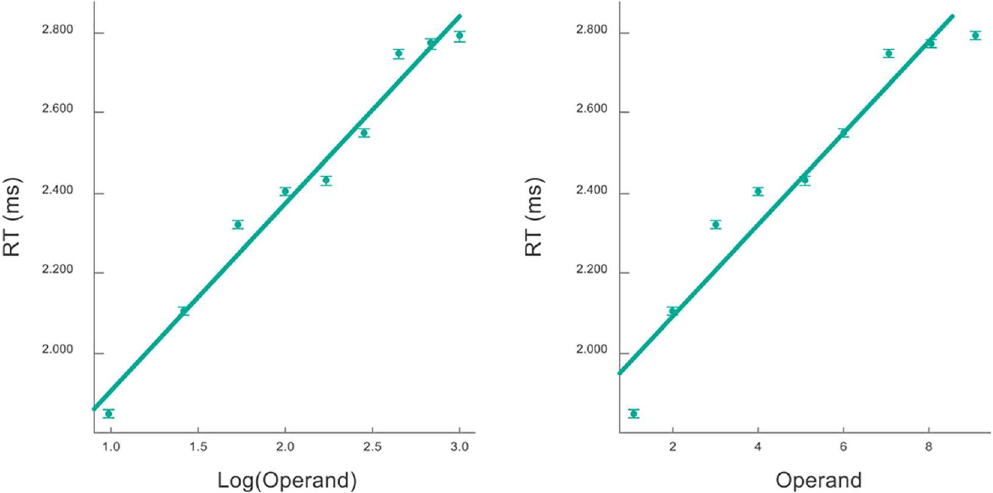
Fig 6. Mean RT per operandfor the addition table in linear (right) and logarithmic (left) scales. Linearregressions show that the data is best fitted in log scale. Error bars are barelyseen due to the large numberof